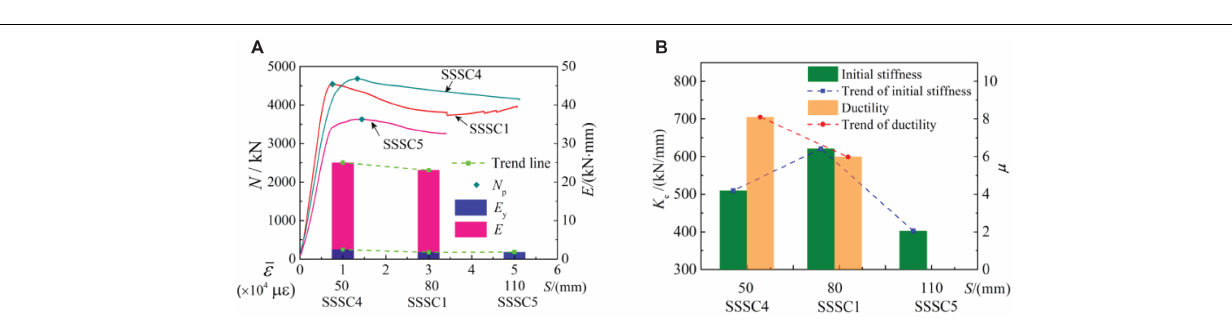
FIGURE 8 | Effect of stirrup side length. (A) Variation of peak load, strain, and energy dissipation. (B) Stiffness degradation and ductility.